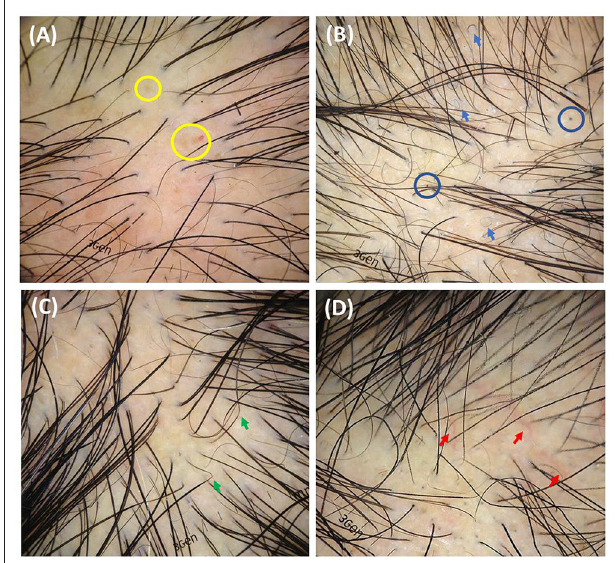
FIGURE 2 | Trichoscopic features of syphilitic alopecia (original magnification x20): (A) decreased hair per follicular unit, empty follicles, yellow dots (yellow circles), and erythematous background; (B) short regrowing hairs, pigtail hairs (blue arrows), broken hairs, black dots (blue circles), perifollicular and interfollicular scales; (C) zigzag hairs (green arrows), black dots, and empty follicles; (D) decreased hair per follicular unit, black dots, and telangiectasia (red